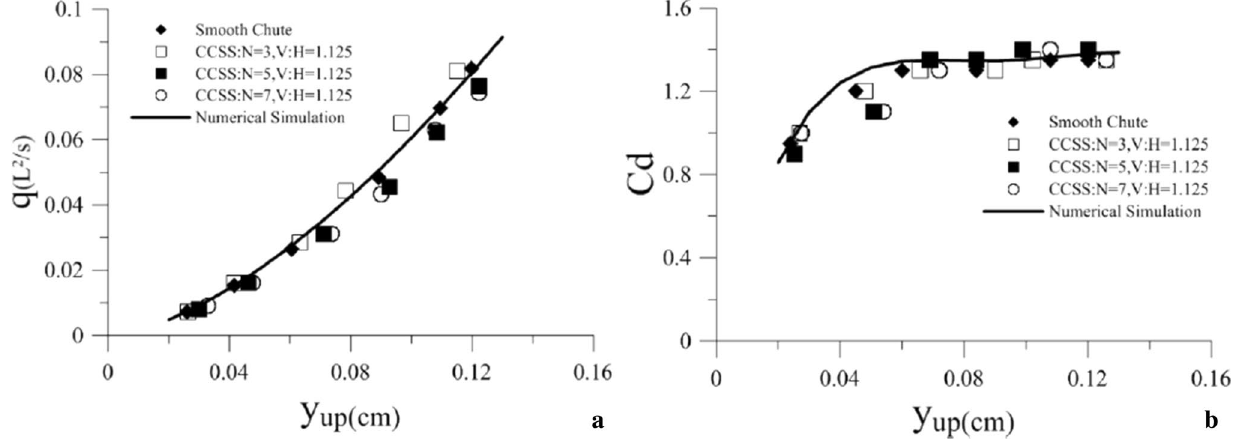
Fig. 4 The results of numerical modeling of stage–discharge ( a ) and discharge coefficient ( b ) of the